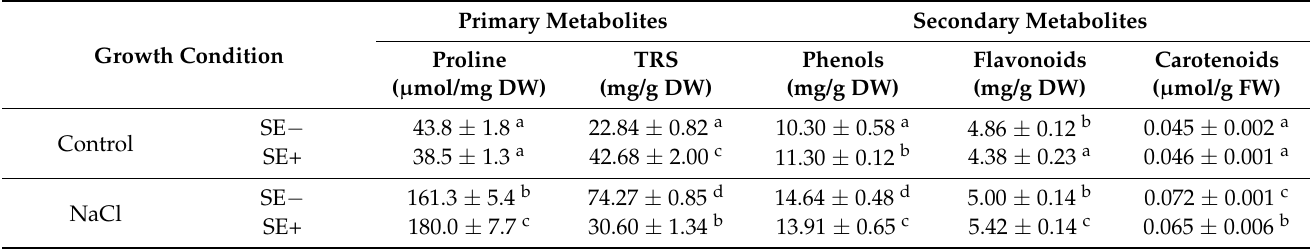
Table 4. Metabolites present in the tomato plants at the vegetative stage.